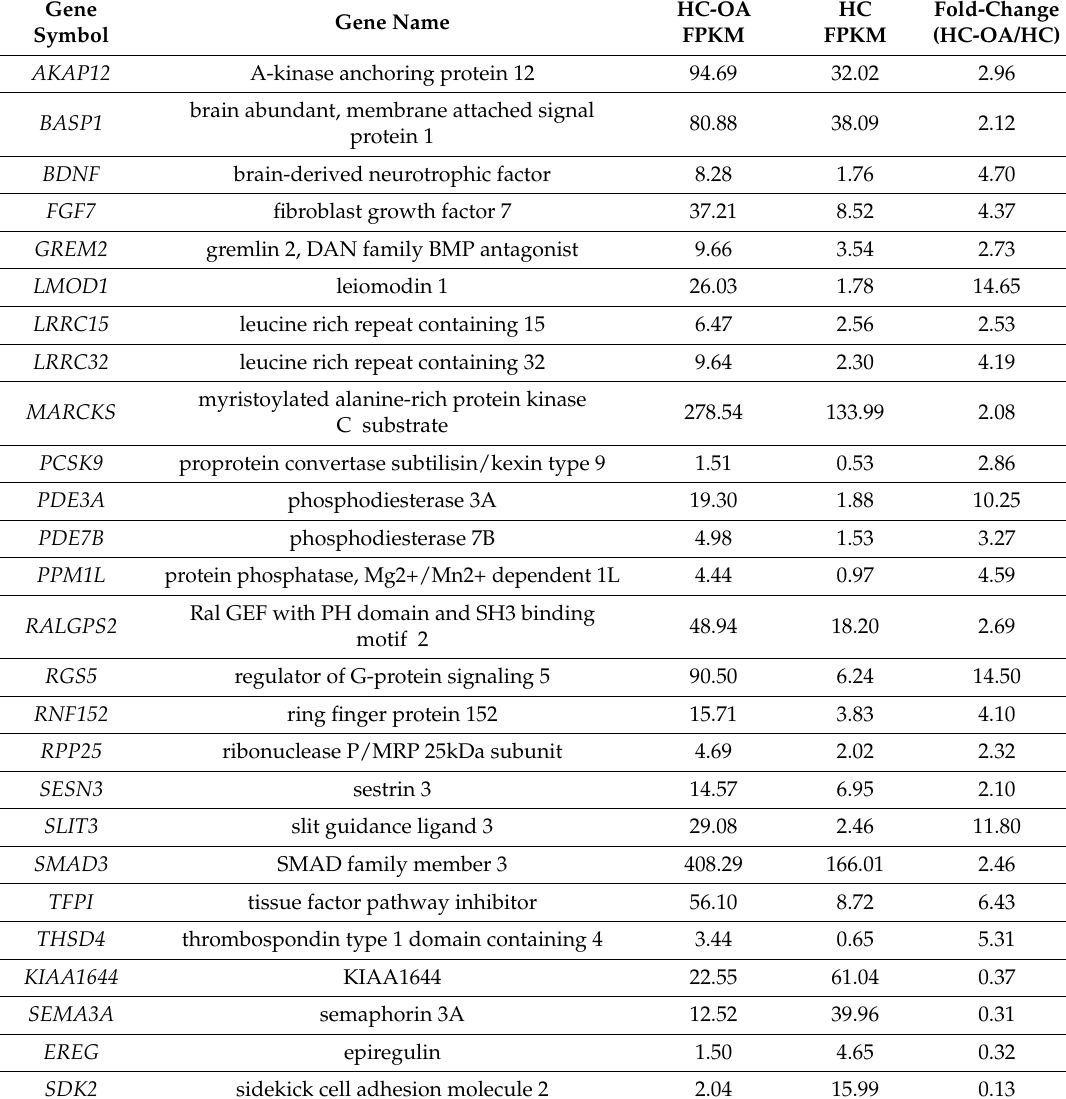
Table 3. Candidate genes of OA knee chondrocytes identified from putative targets of